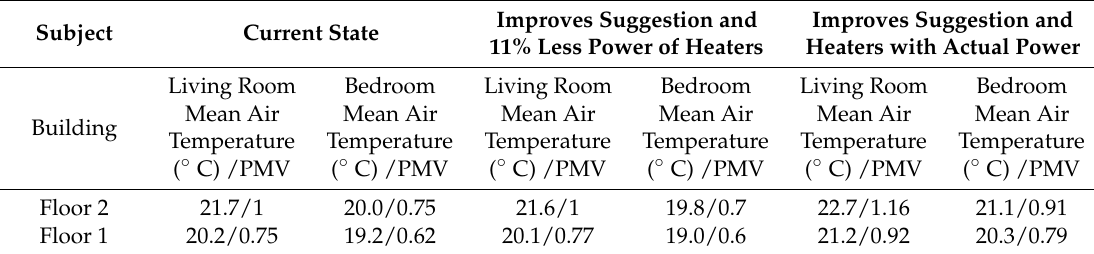
Table 7. Results obtained through the CFD model.